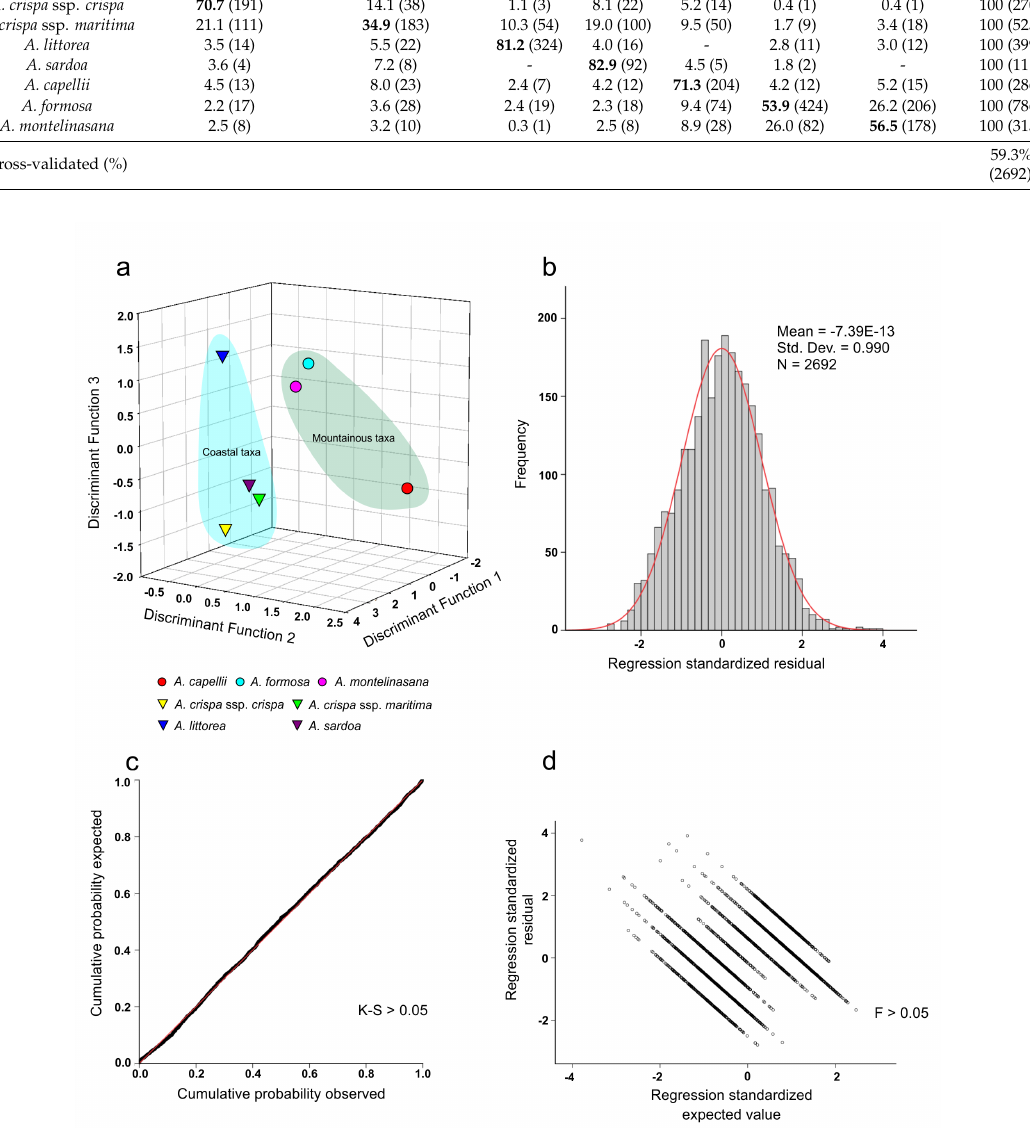
Figure 2. Distribution of the taxonomical groups’ centroids on the basis of three available discriminant functions. ( a ) Graphical representation of the discriminant scores of the seven Anchusa taxa; ( b ) Histogram of the standardized residuals; ( c ) Dispersion plot of the standardized residuals tested with Levene’s test (F); ( d ) Normal probability plot (P-P) tested with Kolmogorov–Smirnov’s test